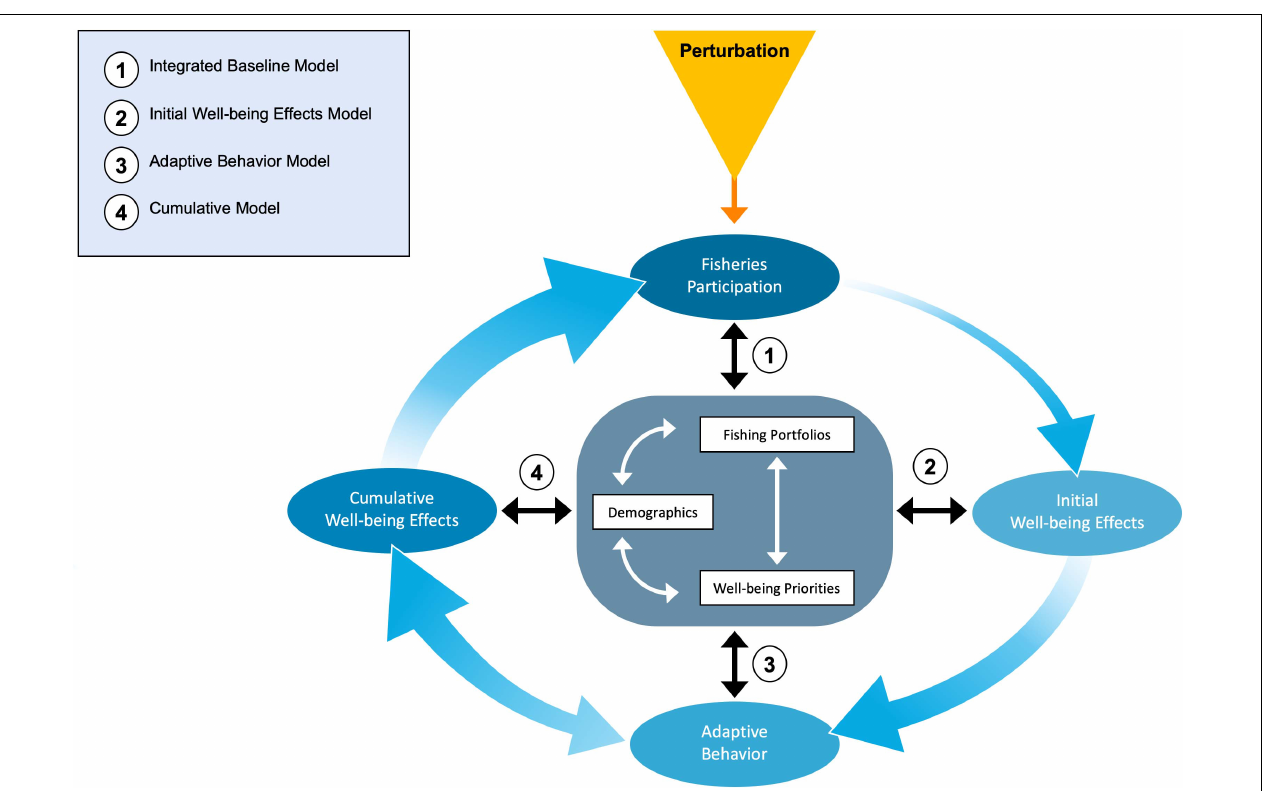
FIGURE 1 | Conceptual framework for integrating human dimensions into ecosystem assessments, including integrated baseline, initial well-being effects, adaptive behaviors, and cumulative impacts that need to be considered in response to a